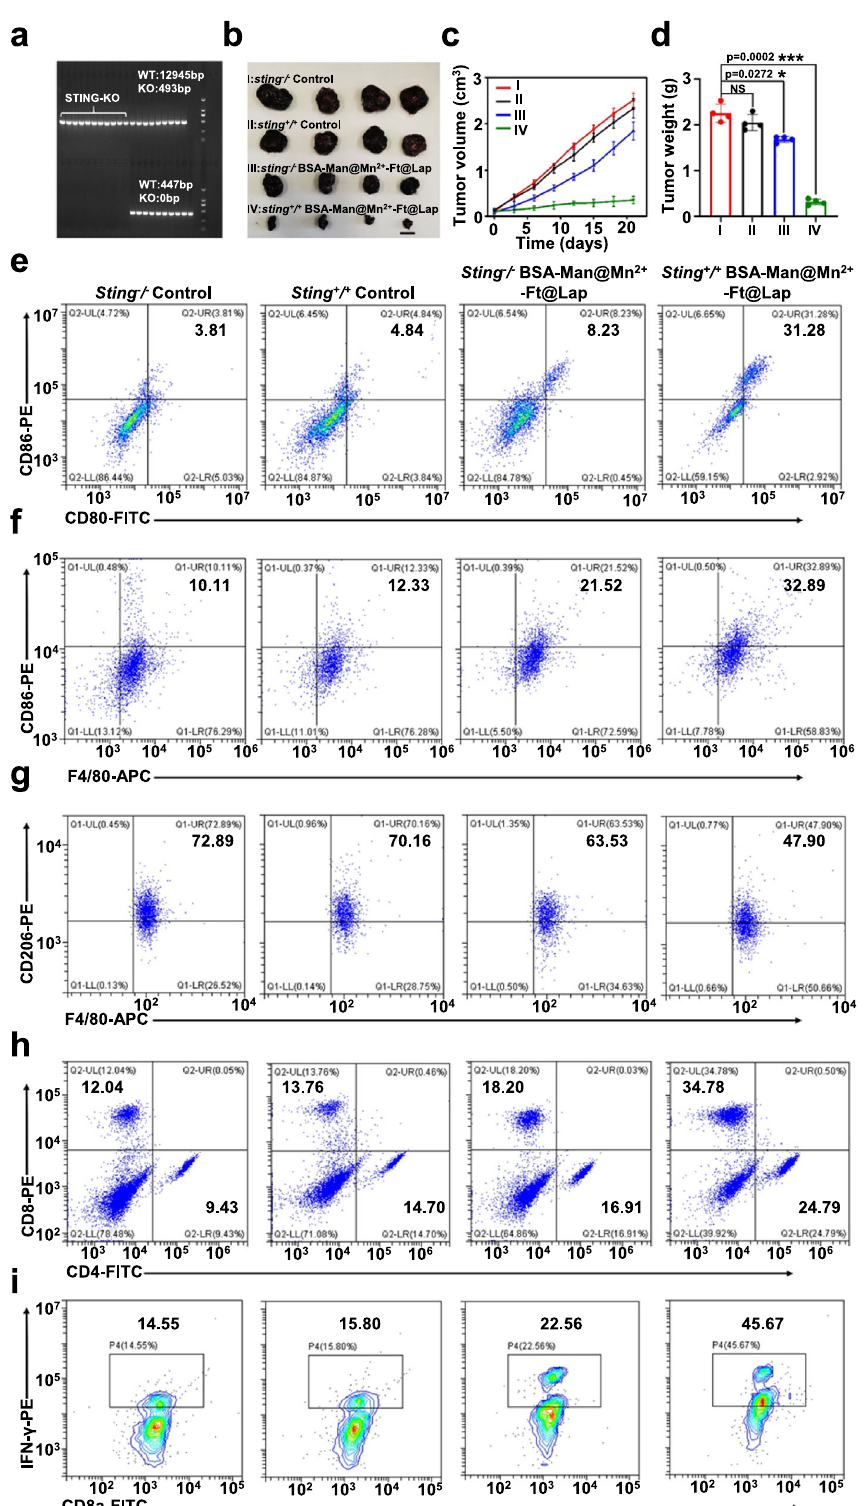
Fig.8|ImmunostimulatoryeffectsofBSA-Man@Mn 2+ -Ft@Lapnanoagoniston STING-KO B16F10 tumor-bearingC57mice in vivo.a PCR assayofthe STING-KO mice ( n =11 mice). b Visual comparison of the nanoagonist-induced antitumor effectsonSTING-KOB16F10tumor-bearing C57mice. Scalebar=1cm. c Change in tumor volumes on STING-KO B16F10 tumor-bearing C57 mice throughout the treatment period. d Weight comparison ofB16F10 tumors on STING-KOmice after different treatments. e – i Flow cytometric analysis on the DC maturation (CD80/